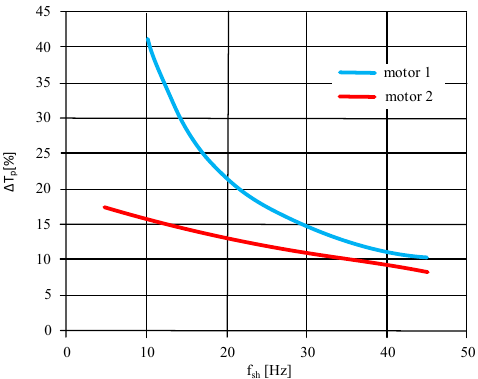
Figure 6. Pulsating torque component ∆ T p of the frequency described with Equation (8) vs. the subharmonic frequency for motor 1 and motor 2.